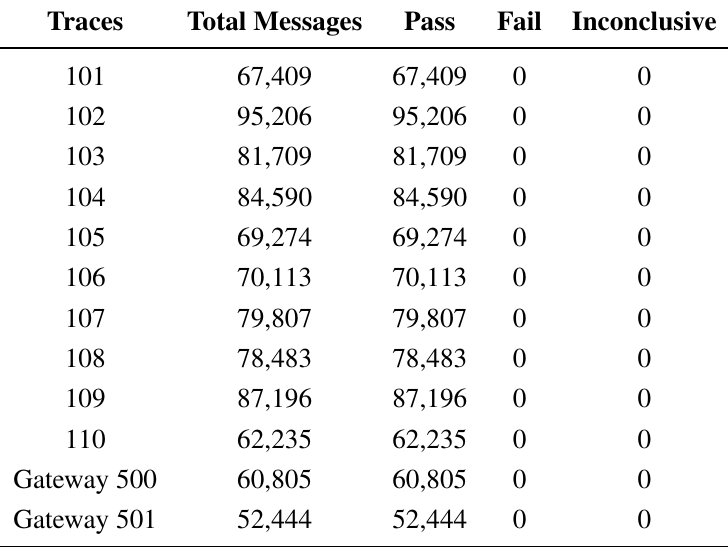
Table 1. Test results for Property